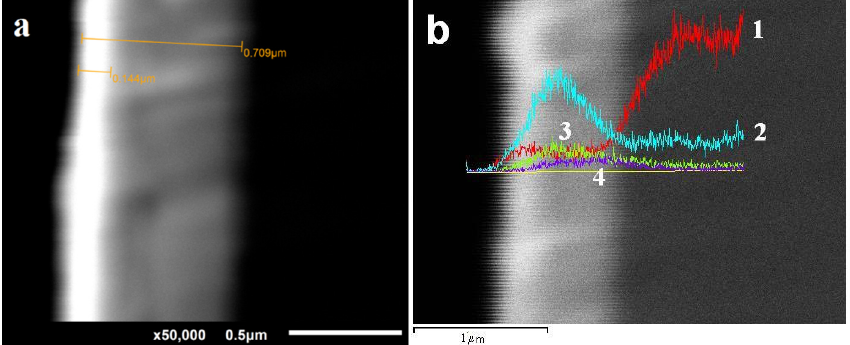
Figure 3. Micrographs of ZnS film “cross ‐ section”: ( а ) thickness in μ m; ( b ) distribution of composition over the film thickness in wt.%. 1 ‐ silicon, 2 ‐ zinc, 3 ‐ sulphur, 4 ‐ tin.